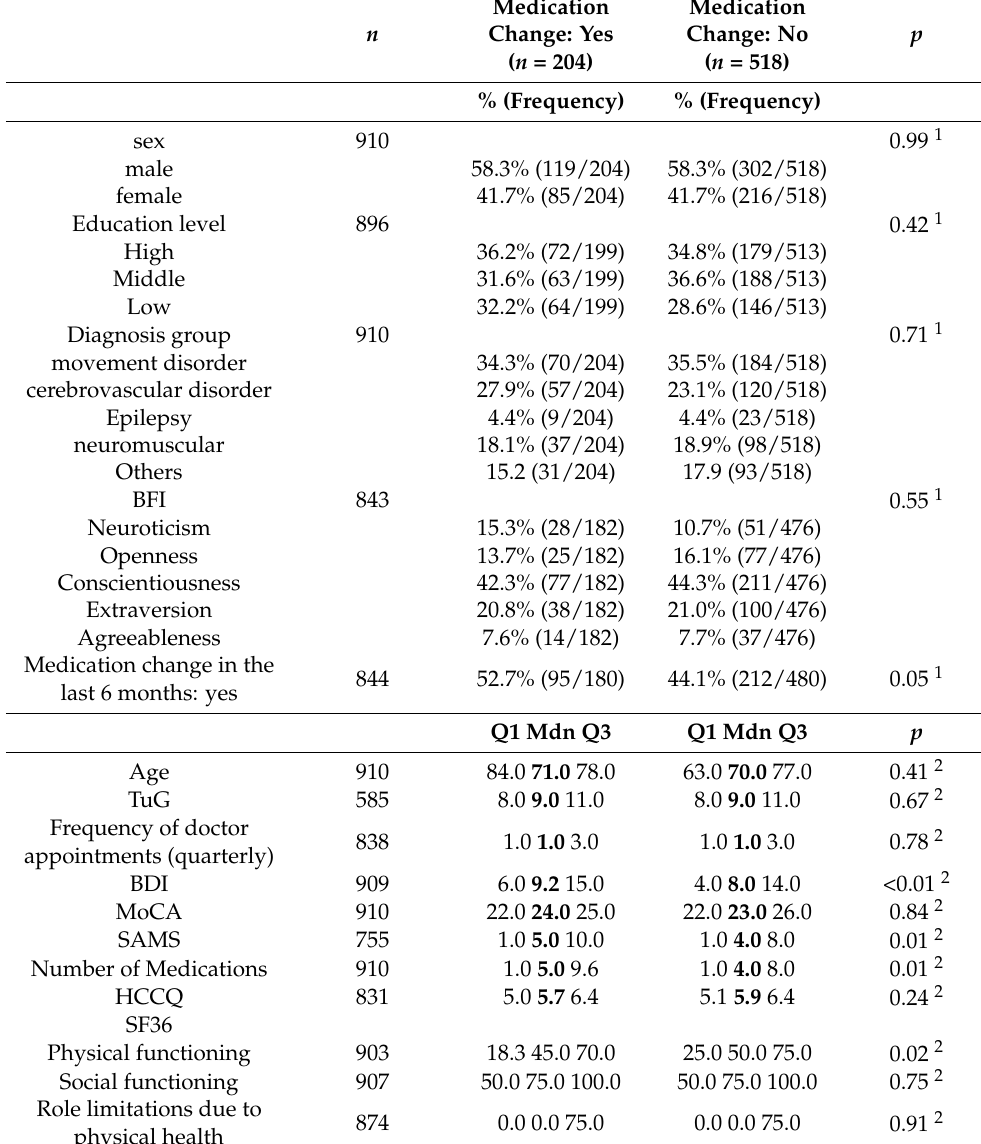
Table 1. Group comparison: cross table for dependent medication change after discharge.